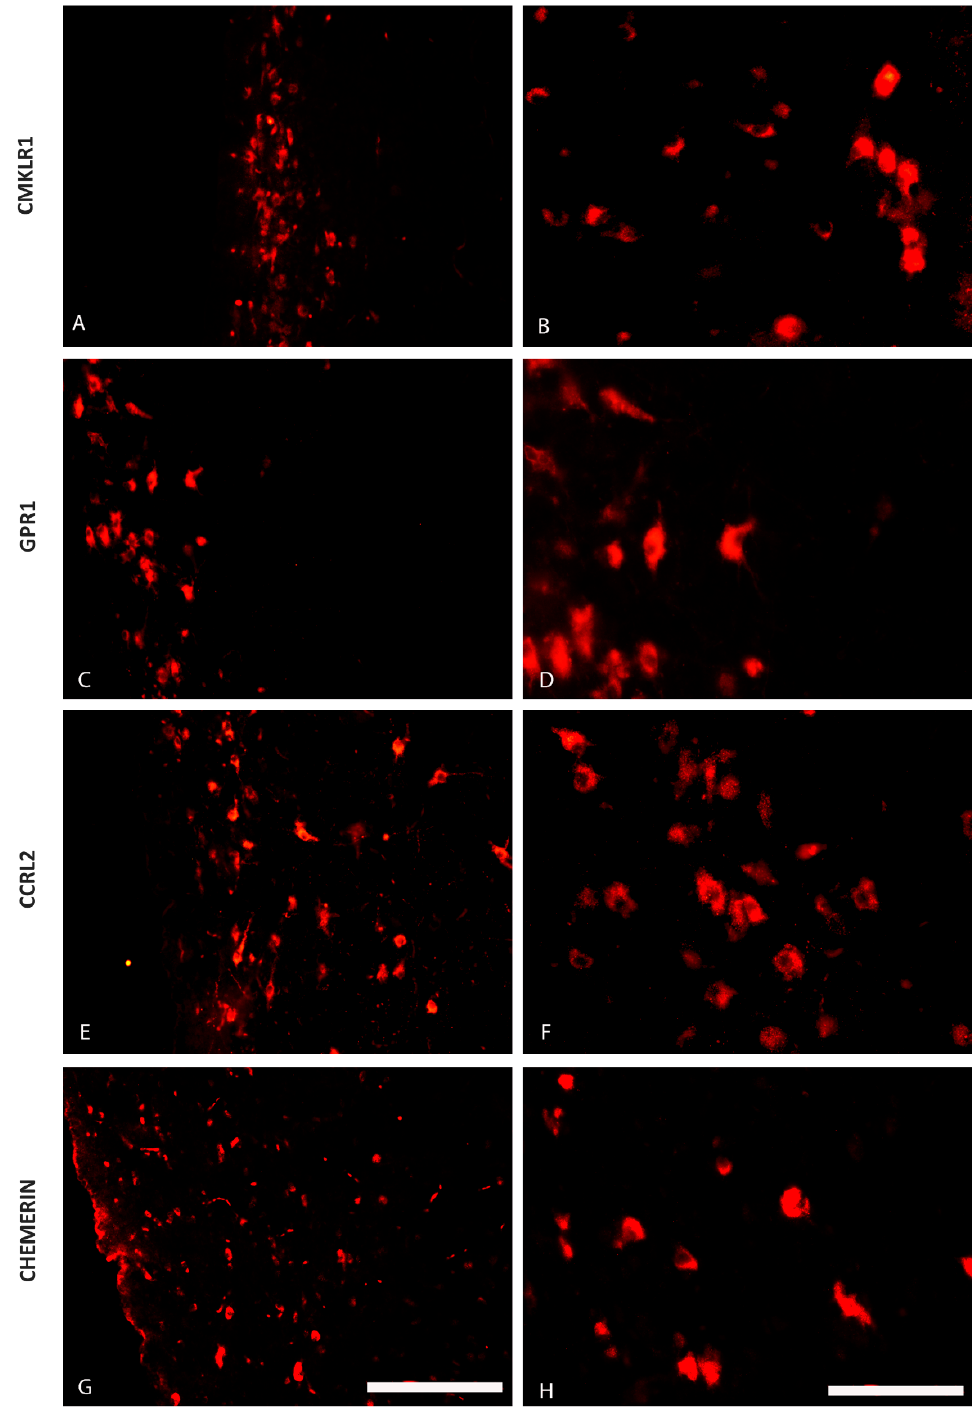
Figure 3. The distribution of the chemerin system in the porcine mediobasal hypothalamus (MBH) during early pregnancy. Immunoreactivity of chemokine-like receptor 1 (CMKLR1; A and B ), G protein-coupled receptor 1 (GPR1; C and D ), C-C motif chemokine receptor-like 2 (CCRL2; E and F ) and chemerin ( G and H ) during early pregnancy (days 15 to 16) in the hypothalamus of the pig at the level of the paraventricular nucleus. Scale bar: 200 µm, applies to A, C, E, G; scale bar: 100 µm, applies to B, D, F, H.